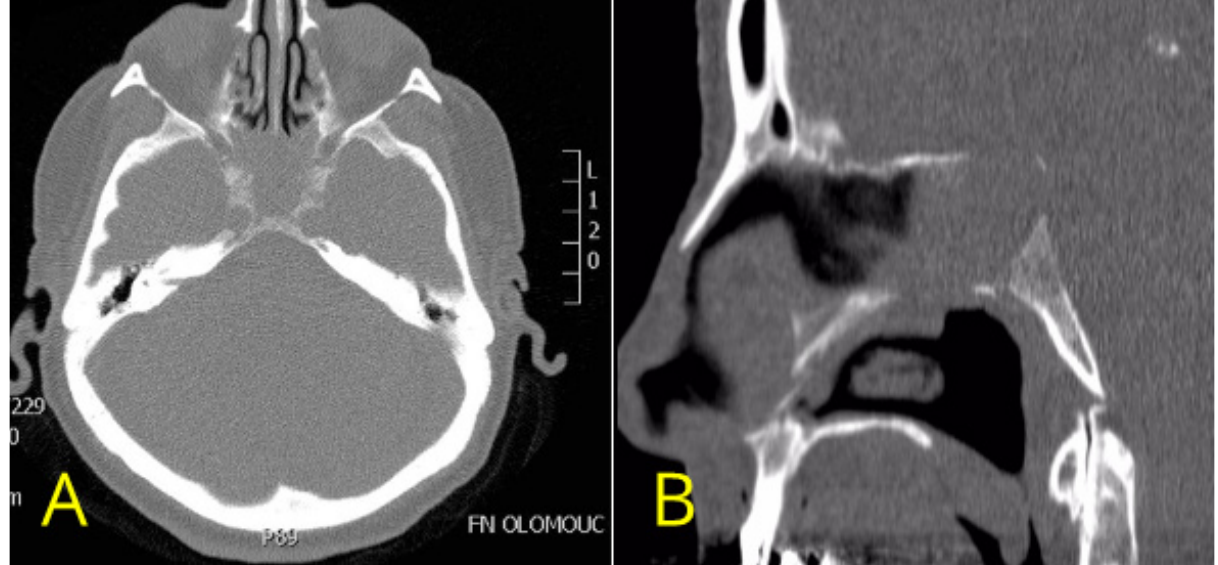
Fig. 2. Brain CT, A – axial scans, B – sagittal scans. Showing the missing vomer, the anterior wall of the sphenoid cavity and the base of the Sella